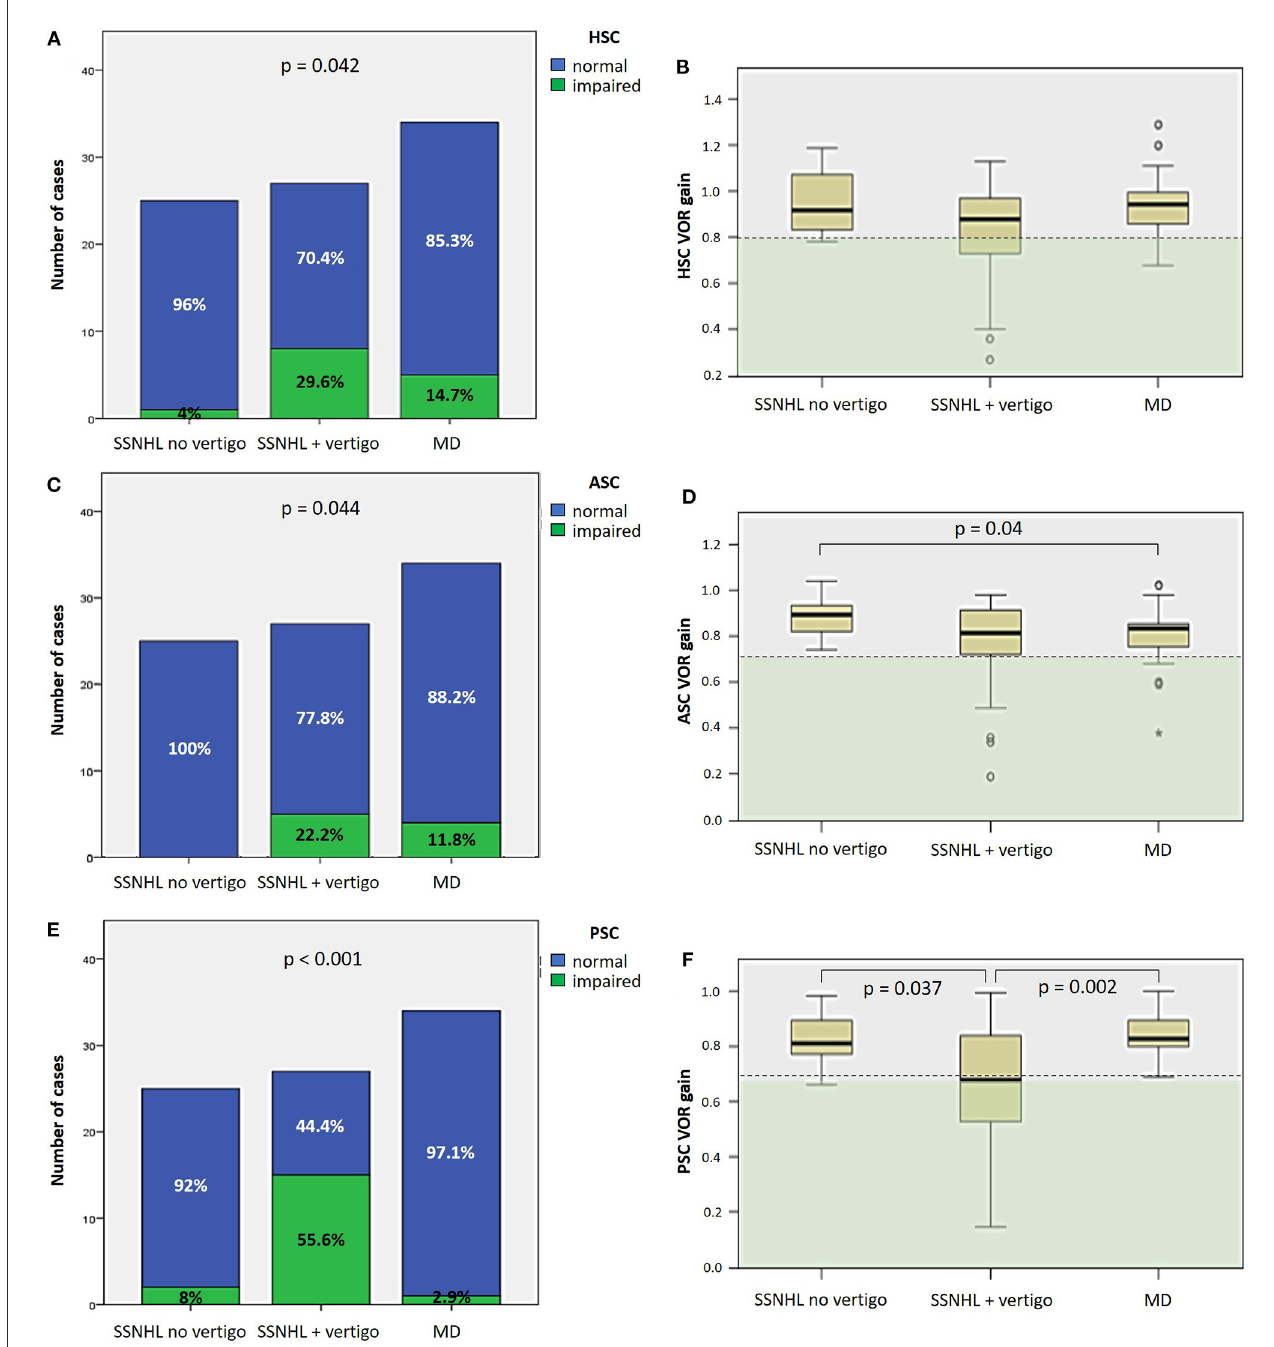
FIGURE4 Different distribution of semicircular canal dysfunction, as assessed by vHIT, among different subgroups based on clinical course. (A, C, E) Bar plots showing the distribution of impaired HSC (A) , ASC (C) and PSC function (E) of the side affected by SSNHL among different subgroups. Relative percentages are reported in each column and p -values of categorical comparisons are reported. (B, D, F) Box plots correlating median values of HSC (B) , ASC (D) , and PSC VOR gain (F) among subgroups. Statistically significant differences at the ANOVA test are shown. ASC, anterior semicircular canal; HSC, horizontal semicircular canal; MD, Menière’s disease; PSC, posterior semicircular canal; SSNHL, sudden sensorineural hearing loss; VOR, vestibulo-ocular reflex; vHIT, video-head impulse test.